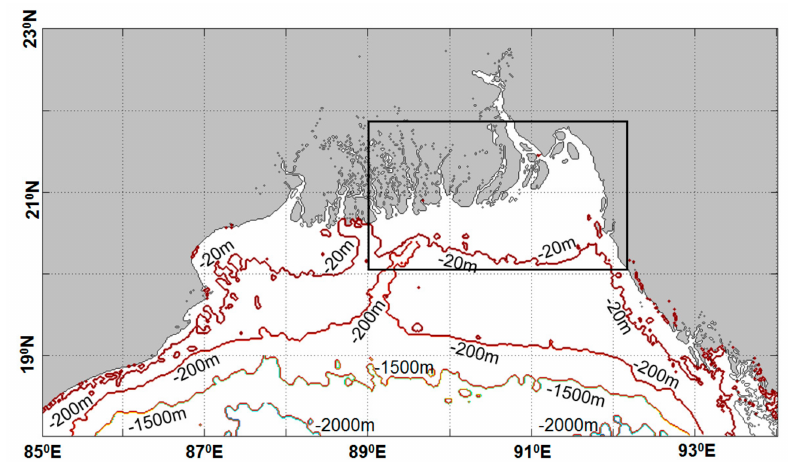
Figure 2. Computation domain along with Bathymetry of northern Bay of Bengal. The inner rectangle shows the coastlines along the Bangladesh coast.